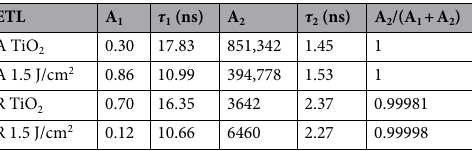
Table 1. Parameters of the TRPL spectra of perovskite on different